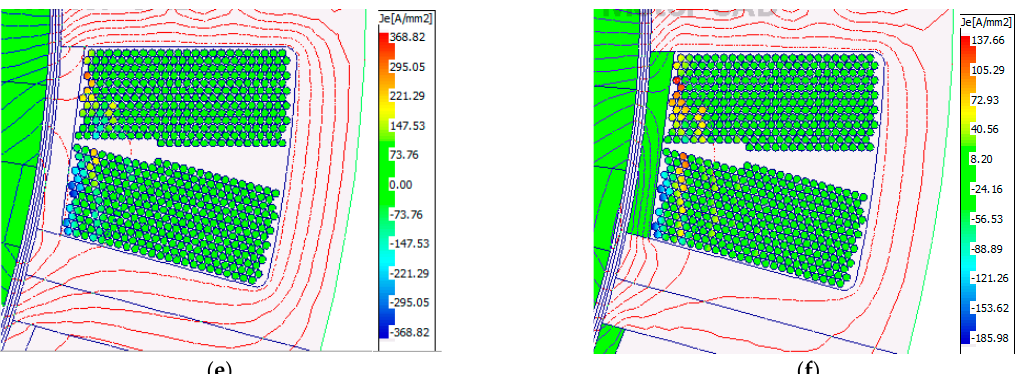
Figure 13. Eddy current density for the SM-W for the 25-strand designs. ( a ) S48-P16, no SM-W, P